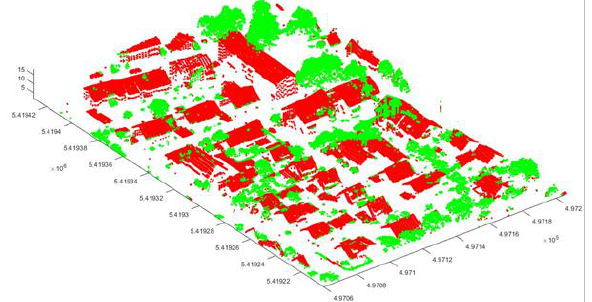
Figure 5. Detection of trees and vegetation points